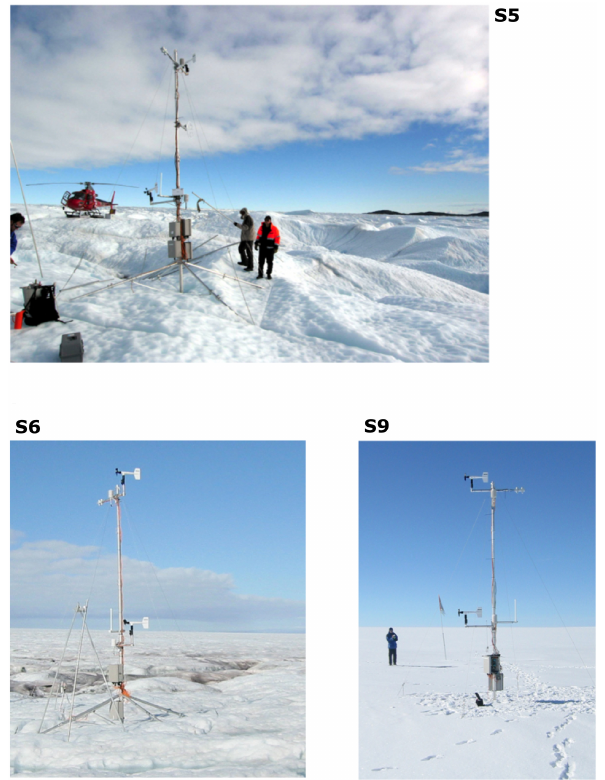
Fig. 3. Images of the AWSs along the K-transect and their sur- roundings at S5, S6 and S9. Images taken at the end of the ablation season (end of August). Photos by Paul Smeets